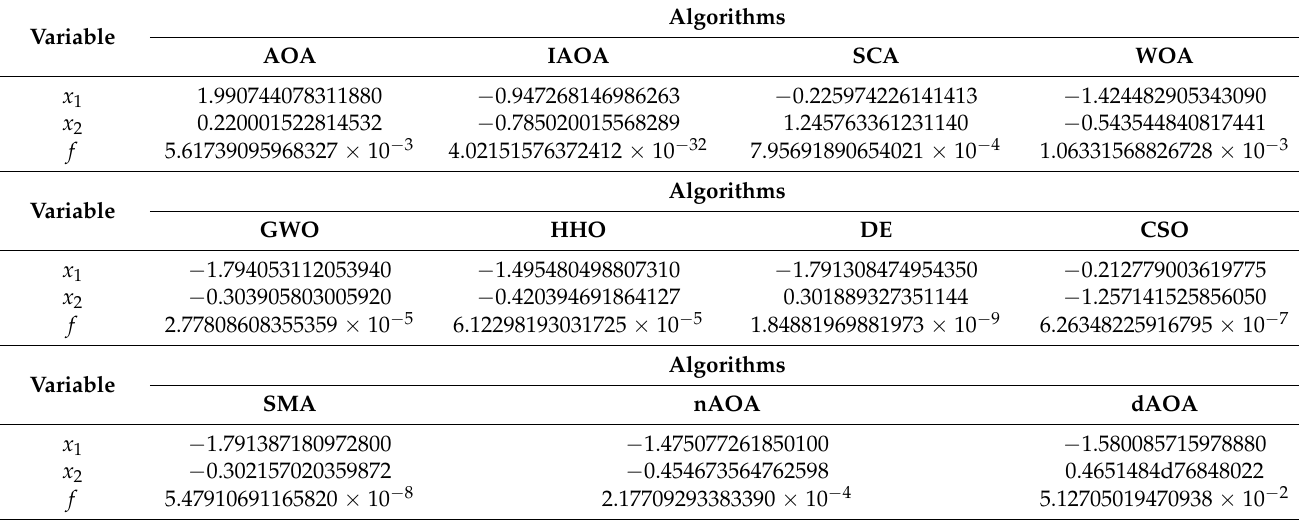
Table 3. Comparison of the experimental results for problem03.